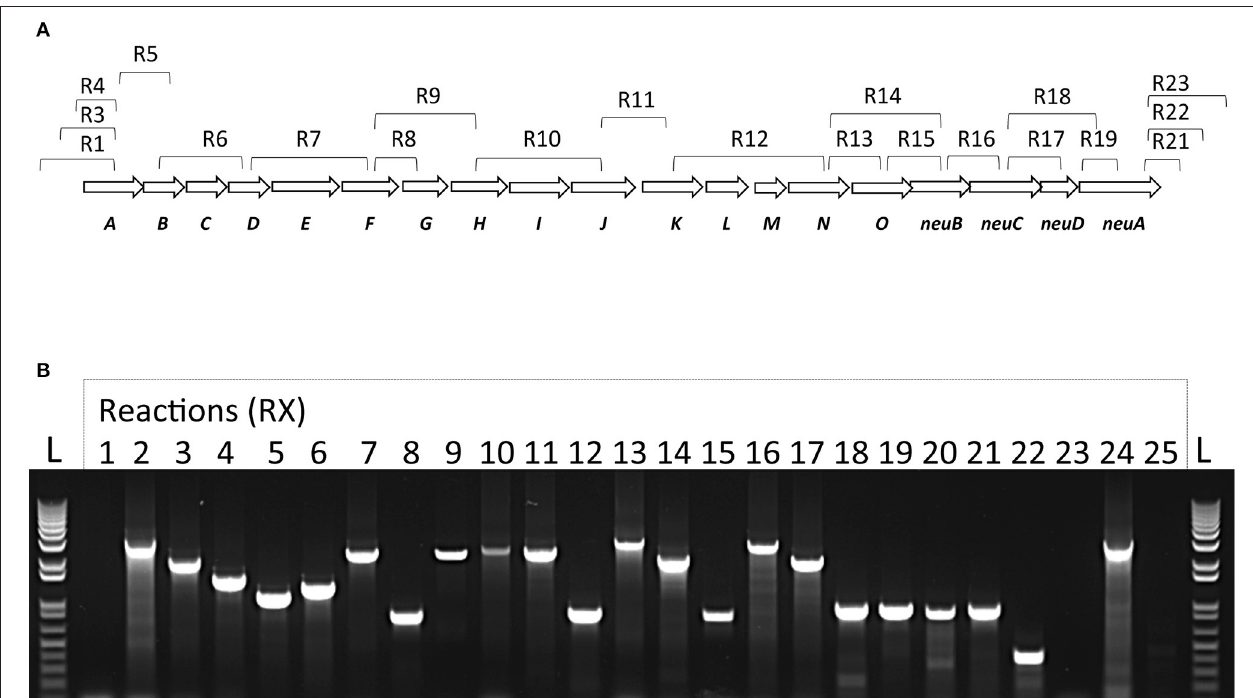
FIGURE 3 | Transcriptional analysis of the S. suis cps operon. (A) Schematic representation of S. suis capsular polysaccharide synthesis coding region with corresponding RT-PCR reactions and (B) agarose gel electrophoresis of RT-PCR reaction products visualized under UV light. Total bacterial RNA was isolated and converted to cDNA. RNA samples without reverse-transcription step were used as template to verify absence of genomic DNA in lane R25. Genomic DNA with the same primers was used as positive control (lane R24). All RT-PCR products migrated accordingly to their expected sizes. DNA size standards (“L”) are depicted at the left- and right-end